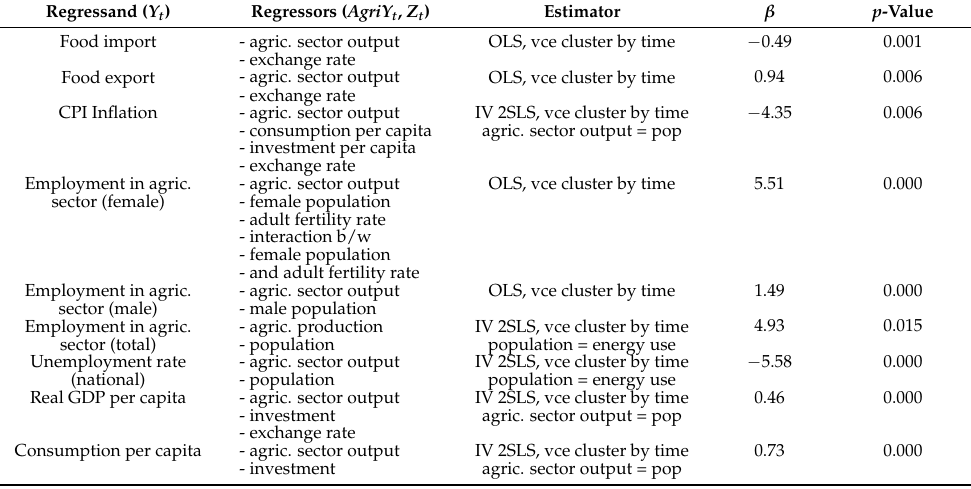
Table A4. Summary of methods for obtaining elasticity coefficients for selected variables with respect to agricultural sector